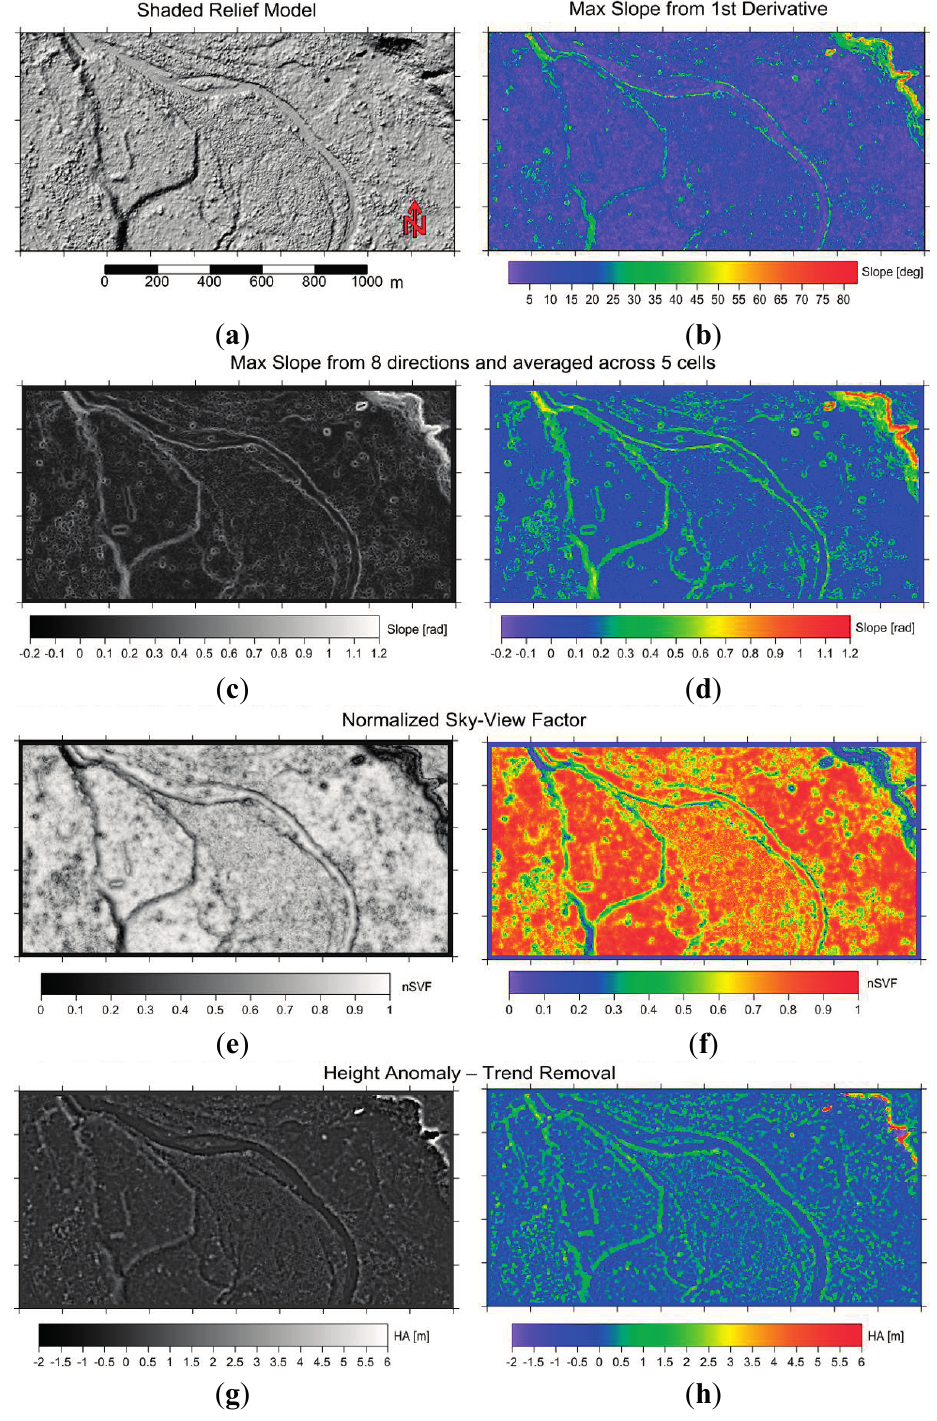
The first row shows a standard shaded relief image of the area with standard illumination and a simple maximum slope computation, where the slope is computed as the elevation